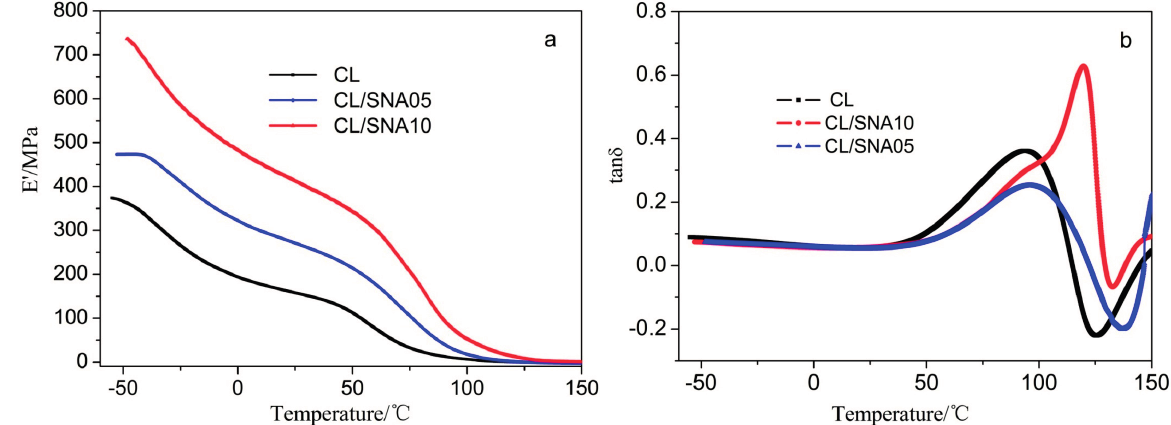
Figure 7. Dynamic mechanical response of CL and CL/SNA nanocomposite films as a function of temperature, recorded at 1 Hz frequency ( a ) storage modulus E' and ( b ) loss factor (tan δ